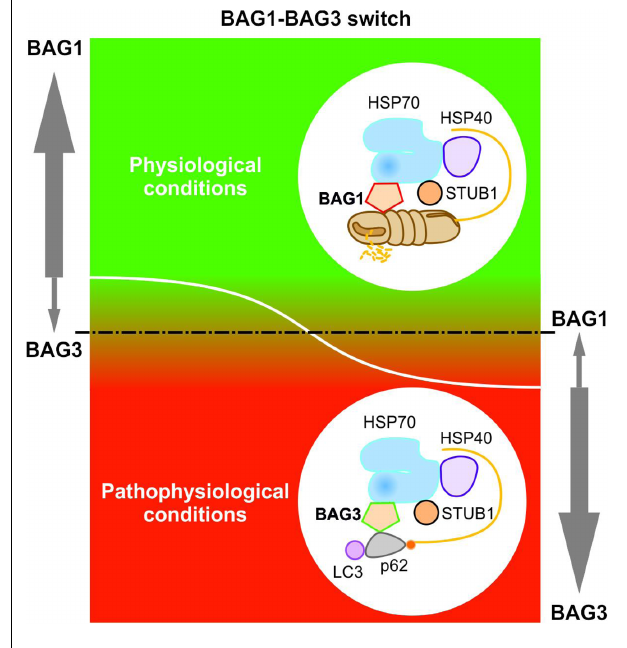
FIGURE 4 | BAG1-BAG3 switch in expression and function. The BAG1 and BAG3 expression levels are reciprocally regulated during cellular aging and under acute stress. Under physiological conditions, a high BAG1 expression, but a low BAG3 expression could be detected; while under pathophysiological conditions, the BAG3 level is elevated and the BAG1 level is decreased. The BAG1 to BAG3 expression switch is accompanied by a functional switch from HSP70-BAG1-mediated proteasomal degradation to HSP70-BAG3-mediated selective